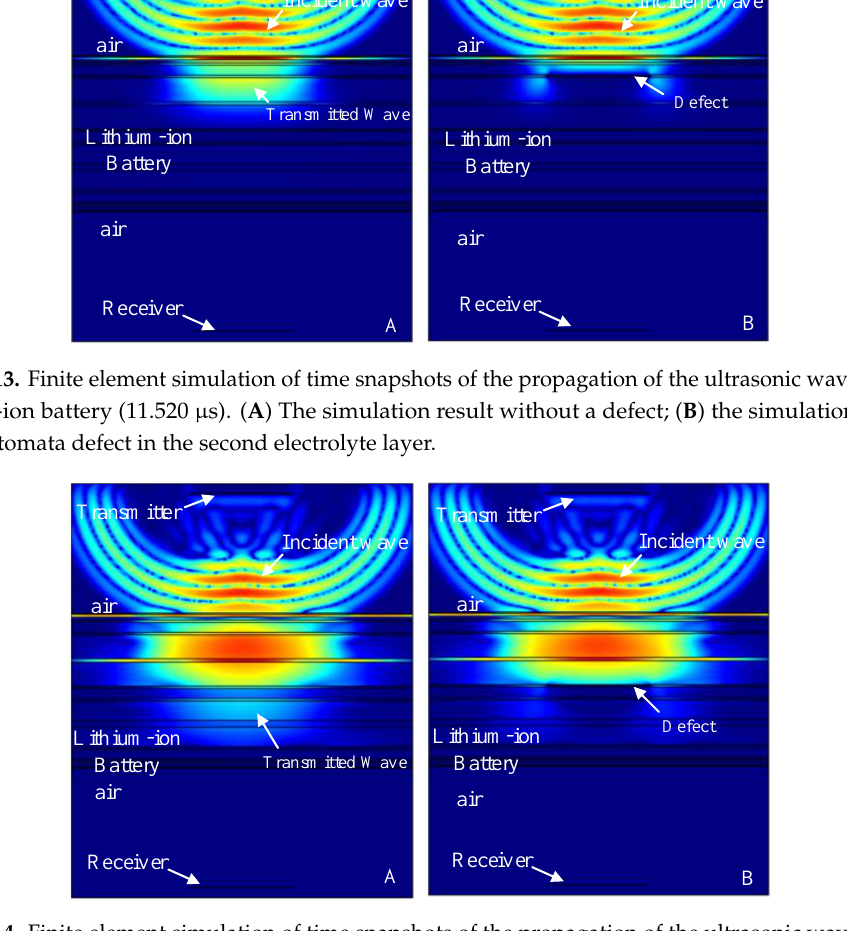
Figure 14. Finite element simulation of time snapshots of the propagation of the ultrasonic wave in the lithium-ion battery (12.060 µ s). ( A ) The simulation result without a defect; ( B ) the simulation result with a stomata defect in the third electrolyte layer.